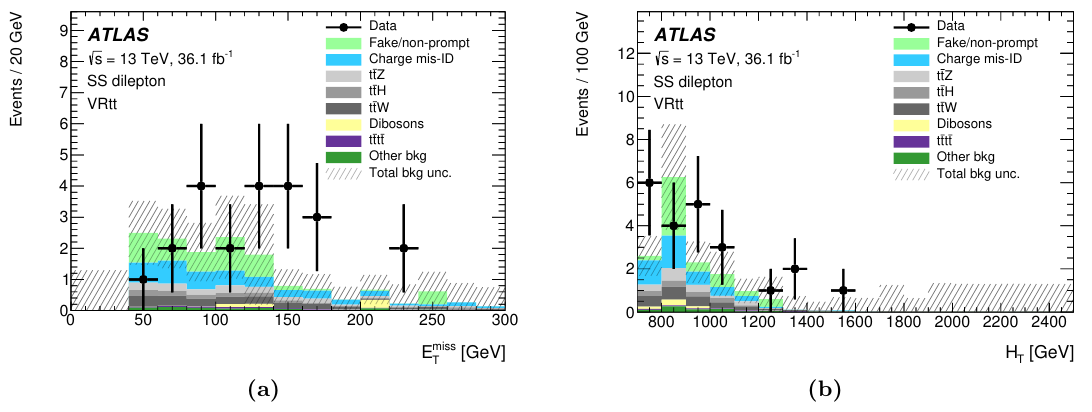
Figure 6 . Distributions of (a) E miss and (b) H T in the validation region used for the same-sign T top-quark pair production search. The uncertainty, shown as the hashed region, includes both the statistical and systematic uncertainties from each background